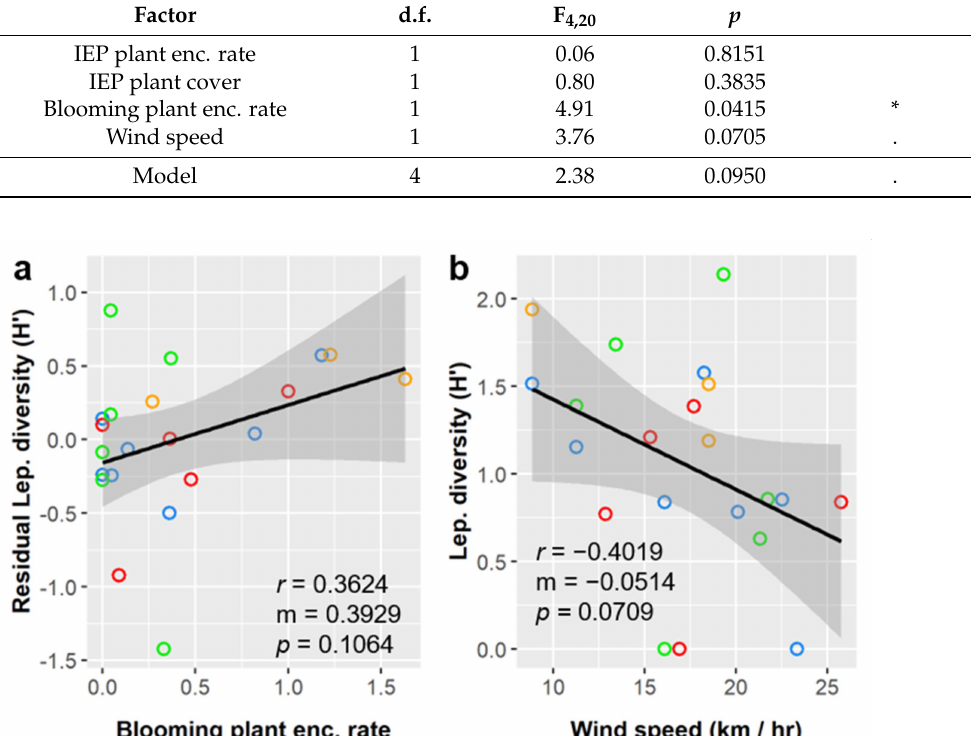
Figure 9. Linear relationships between ( a ) residual Lepidoptera diversity and blooming plant encounter rate and ( b ) Lepidoptera diversity and wind speed. Open circles denote values from one study site and are colored to denote habitat class as follows: red, S TX Disturbed Grassland; orange, Tamaulipan Lomas; green, Tamaulipan Shrubland; blue, Texas Coastal Prairies. Legend: r , Pearson correlation coefficient; m, slope from the regression model (effect size); p , p -value from the simple regression model shown (see Table 8 for p -values from the multiple regression